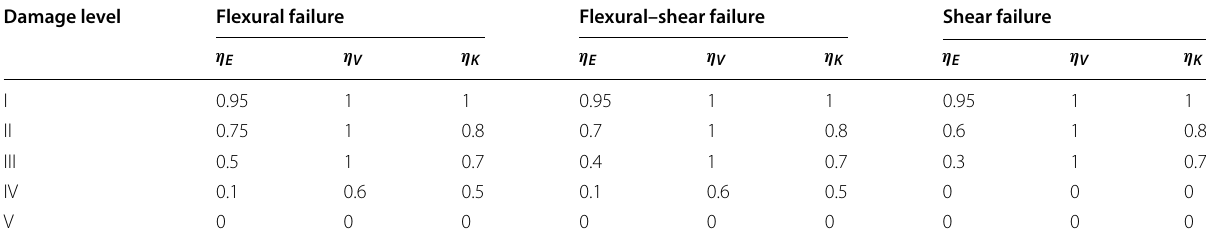
Table 13 Suggested reduction factors of energy dissipation capacity, strength and stiffness for RC column